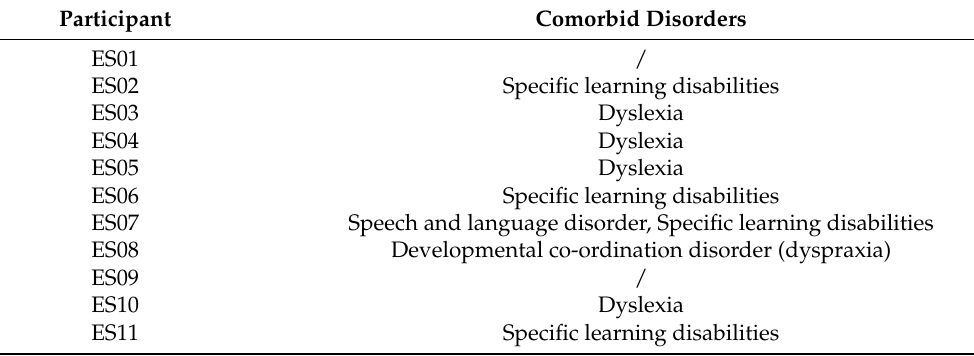
Table 1. Comorbid disorders of children with ADHD.